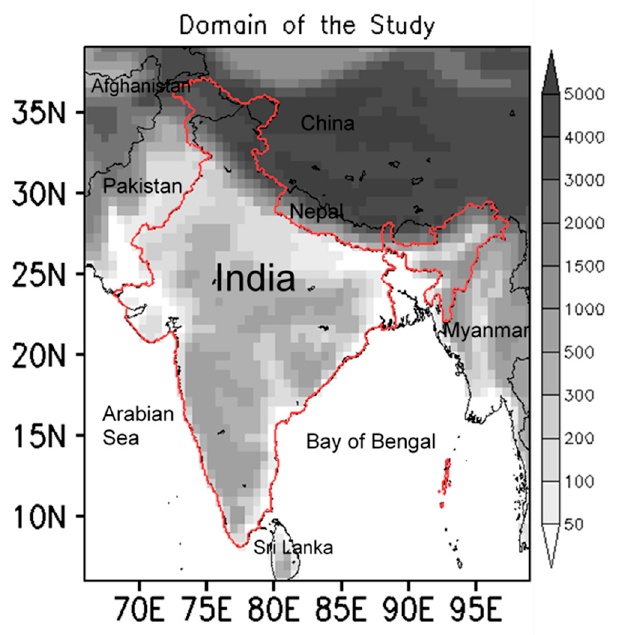
Figure 1. Study region with topography (unit: m). The red colour marked map indicates India.